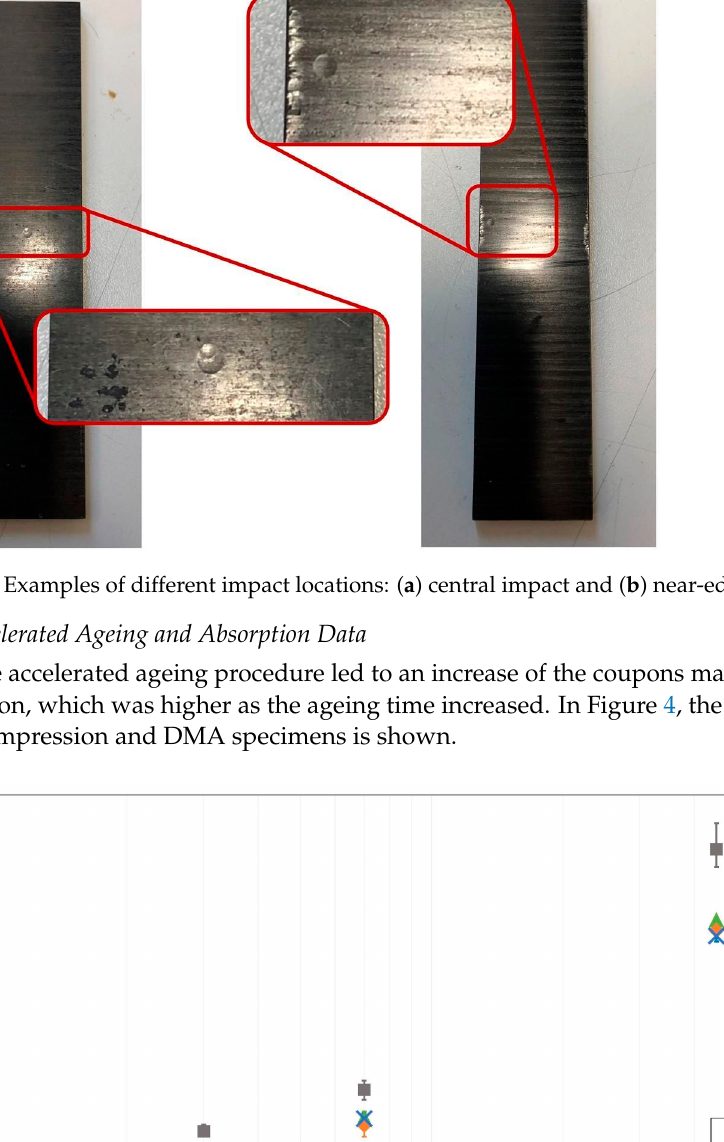
Table 2. Mass variation mean values comparison.